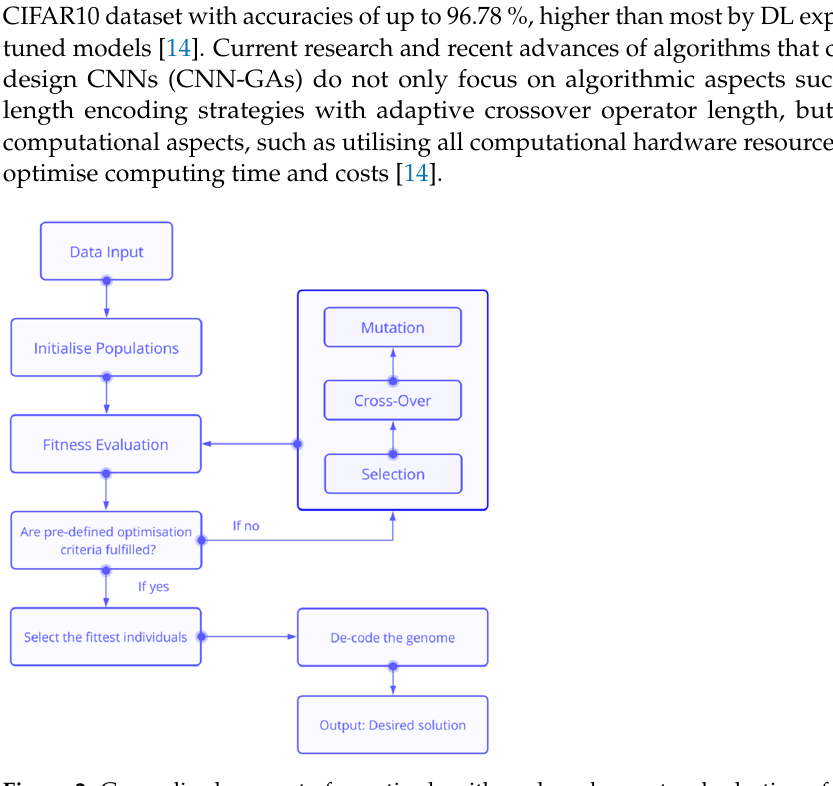
Figure 2. Generalised concept of genetic algorithms; based on natural selection of individuals for offspring creation, randomised cross-over and mutation lead to fit individuals.